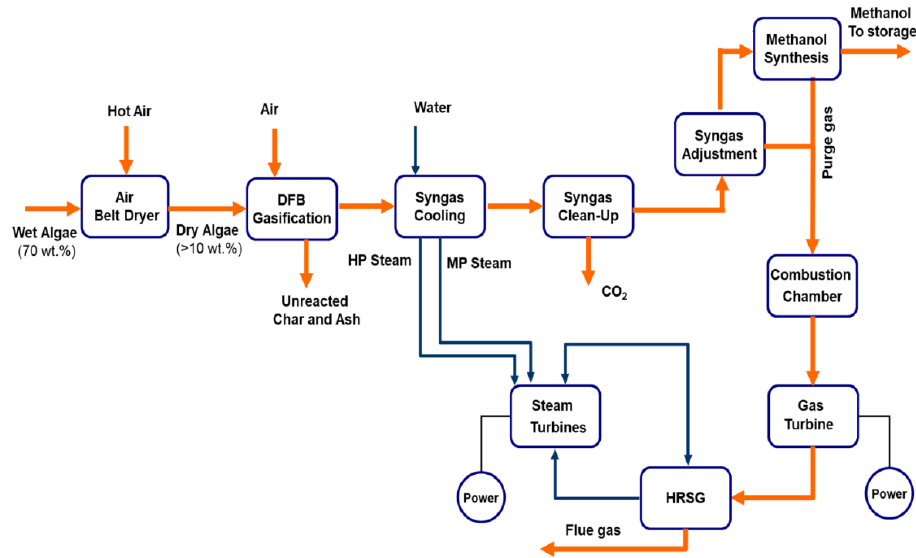
Figure 1. Block flow diagram of the integrated gasification combined cycle with methanol synthesis using a dual fluidized-bed gasifier.